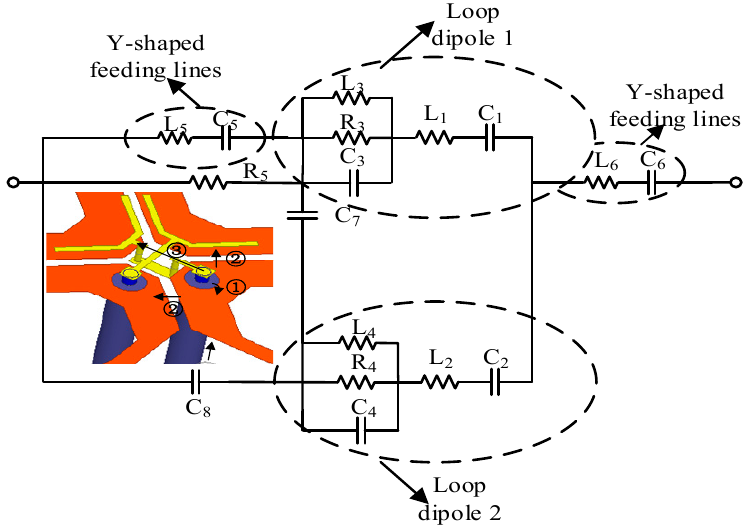
Figure 5. The equivalent circuit of the proposed antenna.